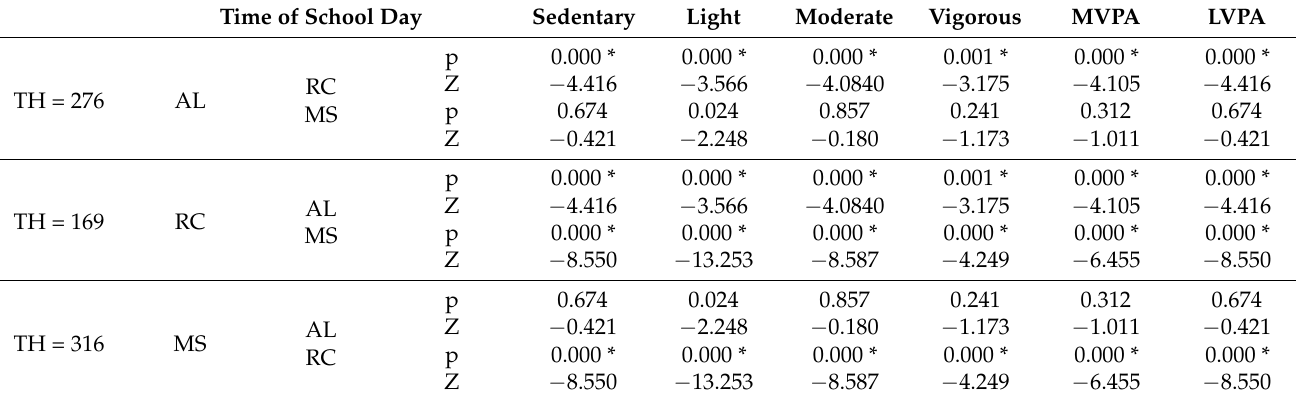
Table 8. Differences between PA intensities performed in the free time after lunch, recesses and specific motor sessions. Time of School